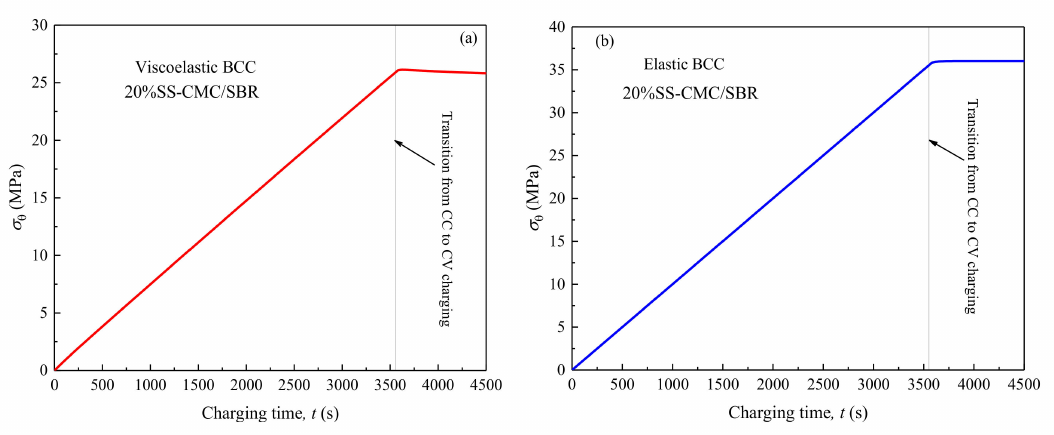
Figure 4. Evolution of hoop stress at solid electrolyte interface (SEI)-BCC interface ( r = b ) over time in the lithiation